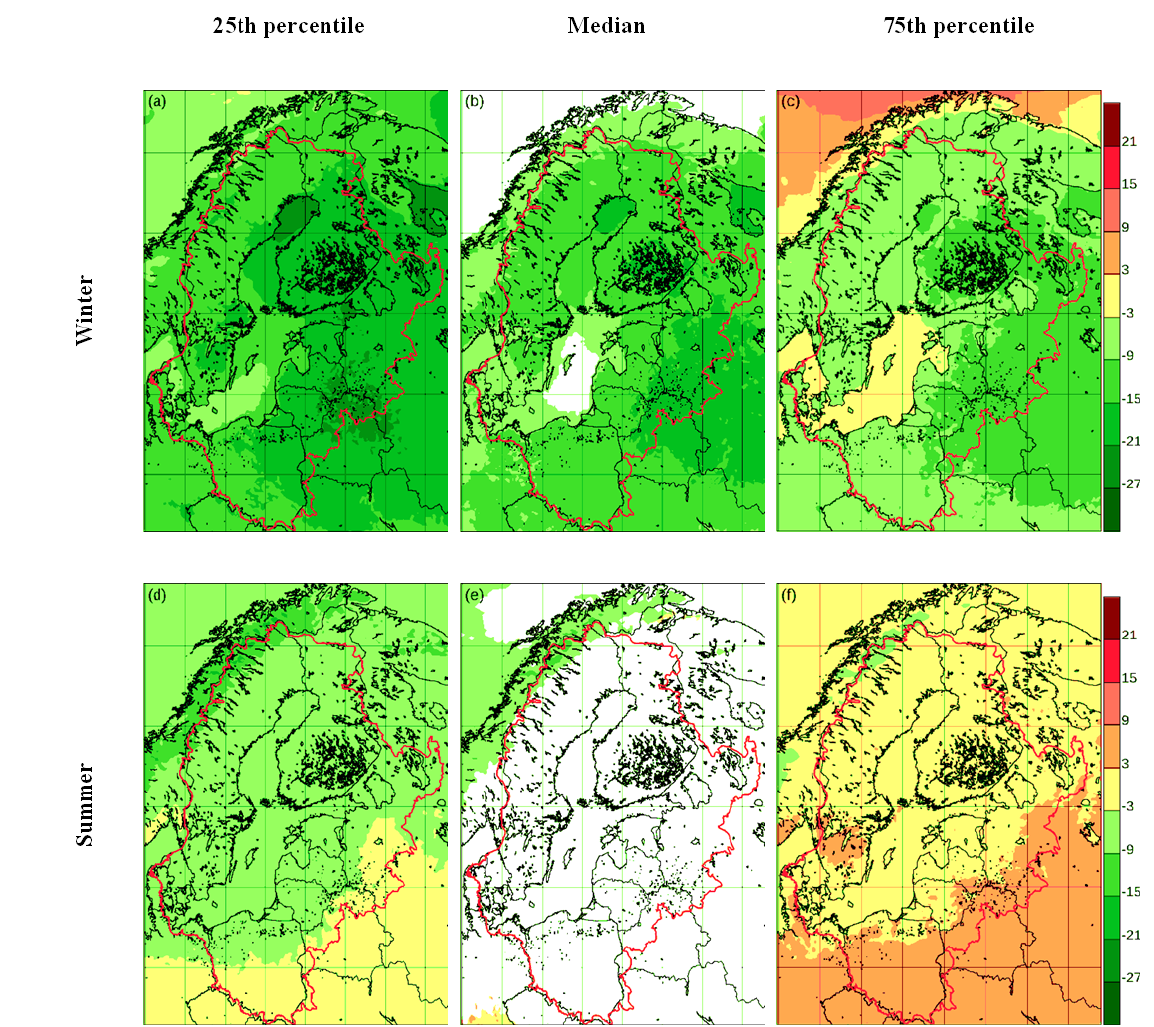
Figure 7. Average incoming surface solar radiation relative change between 1981–2010 and 2071–2100 for 70 simulations from EURO- CORDEX according to the RCP8.5 scenario. (a–c) Winter; (d–f) summer. (a, d) Lowest quartile; (b, e) median value; (c, f) higher quartile. For the medians, only points where 75% of models agree on the sign are shown. The Baltic Sea catchment is indicated in